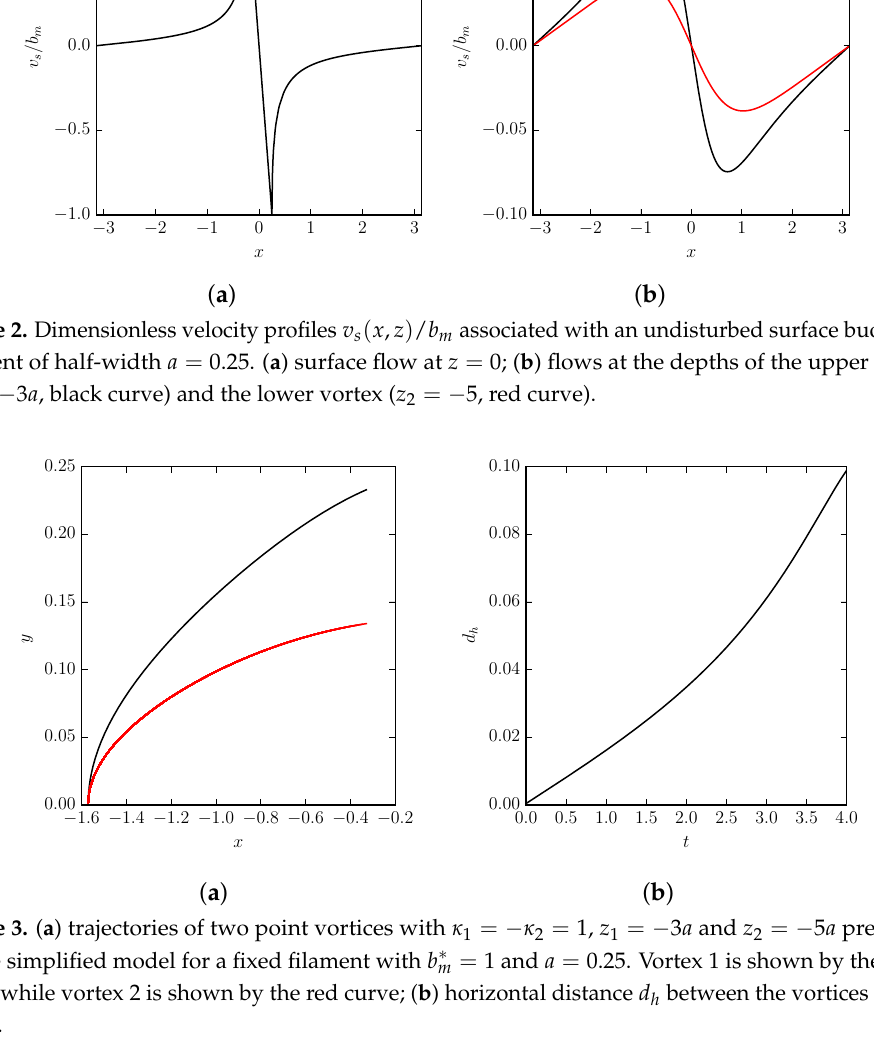
κ 2 = 1, z 1 = 3 a and z 2 = 5 a predicted − − −